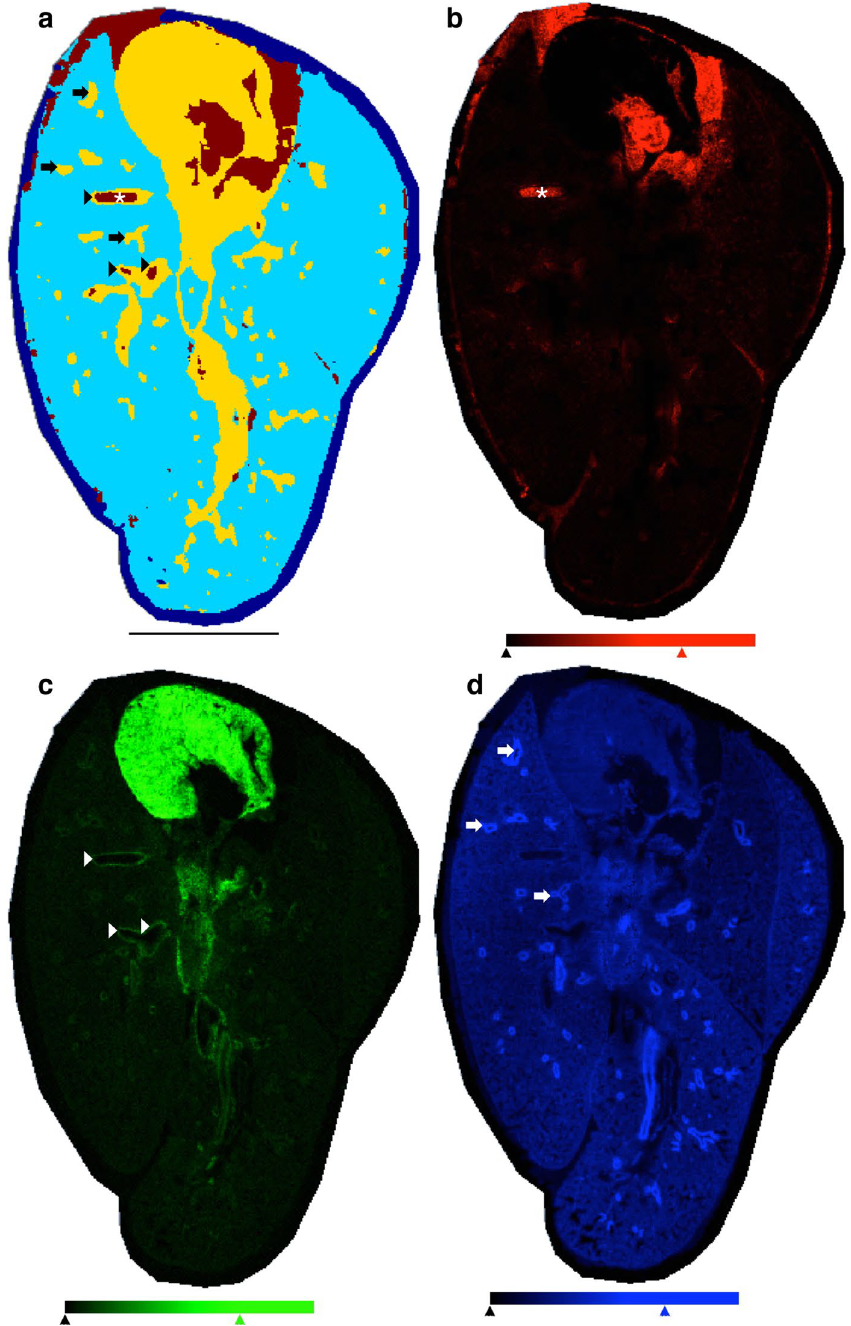
Figure 3. Three-component segmentation of inflated lungs discriminates blood, heart, and airway/vasculature structures matching gross histology and manual annotation. ( a ) Three-component segmented image (three- clusters, on-tissue) given in false color, dark blue component is off-tissue. Scale bar = 5 mm. Reference single channel images given for ( b ) blood - heme ( m/z 615.1, red), ( c ) cardiac tissue - cardiolipin ( m/z 1447.8, green), and ( d ) airway and parenchyma - PI 38:4 ( m/z 885.5, blue). Annotations: asterisk - vessel containing blood, arrowheads - endothelial-lined vascular structures, arrows - epithelial-lined airway structures. MALDI-TOF, negative ion mode, 50 μ m spatial resolution, normalized to TIC. ( b – d ) Single channel images: color reference bars with limiters as shown 0–70% relative intensity, all